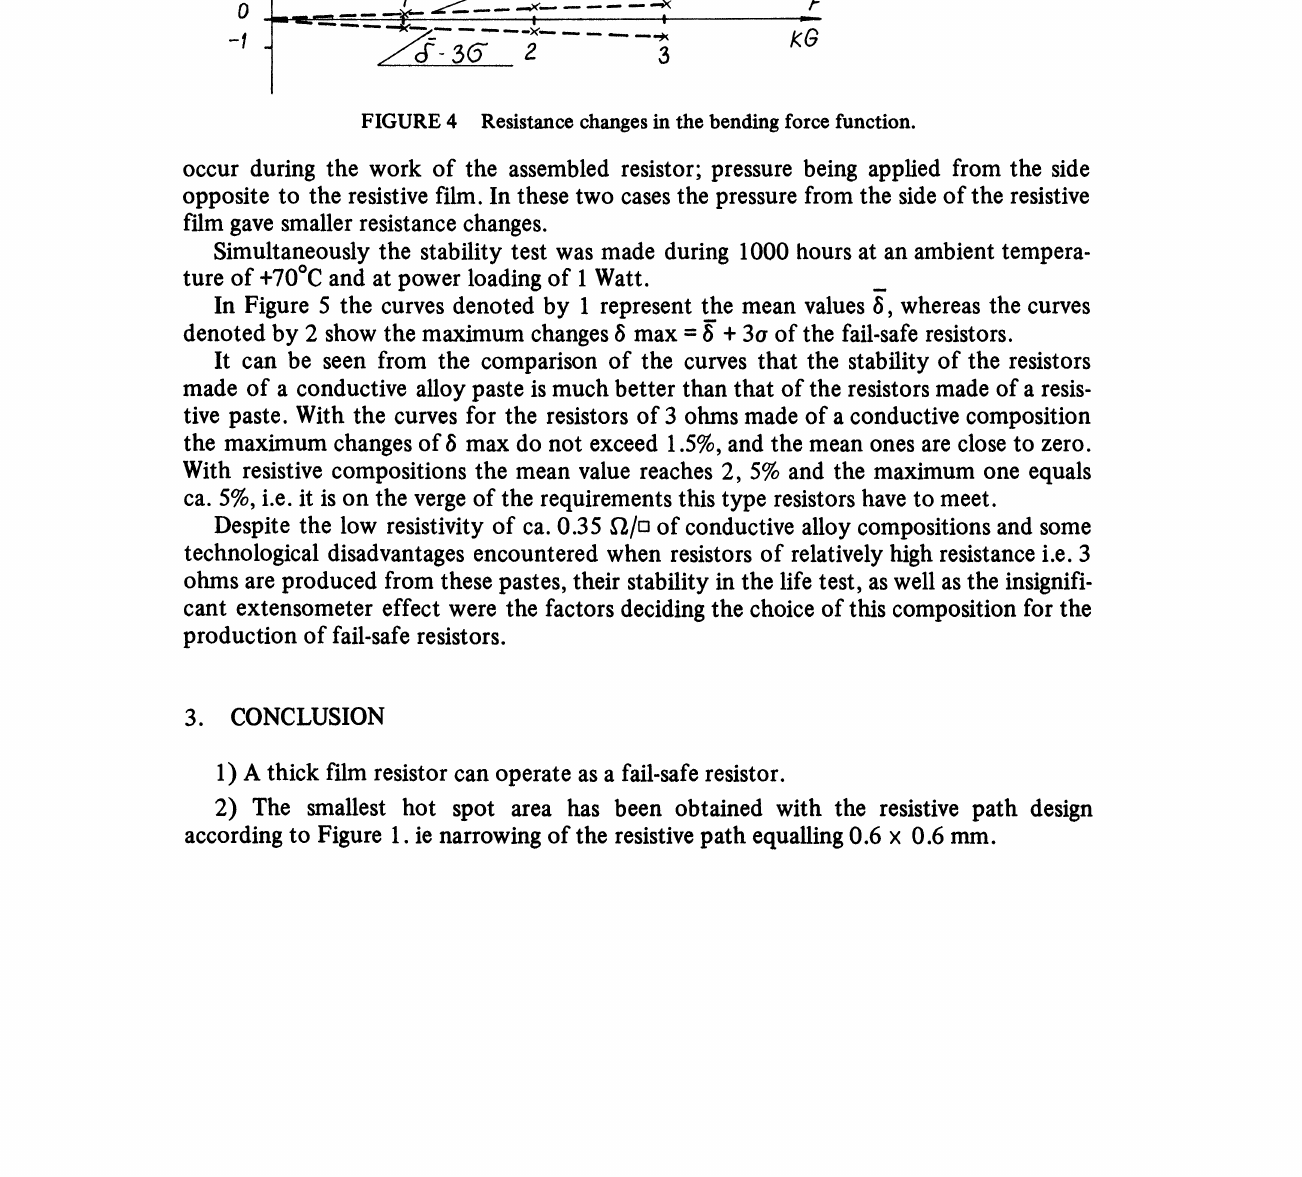
FIGURE 4 Resistce chges in the bending force